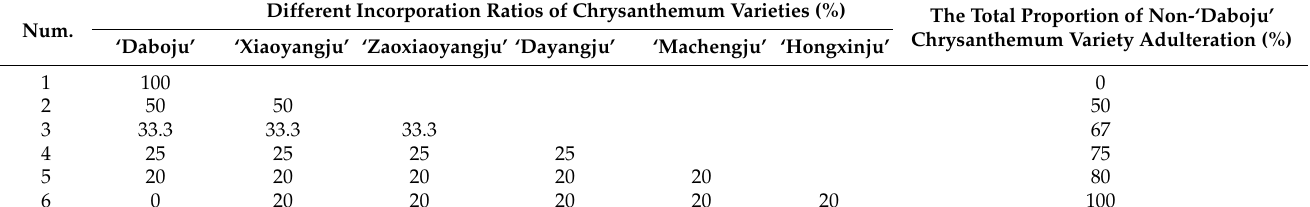
Table 3. Simulated adulteration samples used for SCAR marker DBJF/DBJR application.